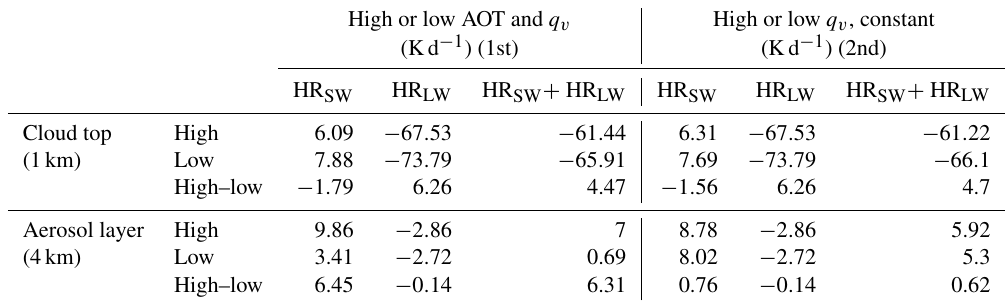
Table 3. Shortwave and longwave heating rate (Kd − 1 ) values for large and low AOT and specific humidity ( q v ) values (first simulation) and for a constant AOT and high and low values of the specific humidity profile (second simulation), obtained at the cloud-top level and at 4km at noon.